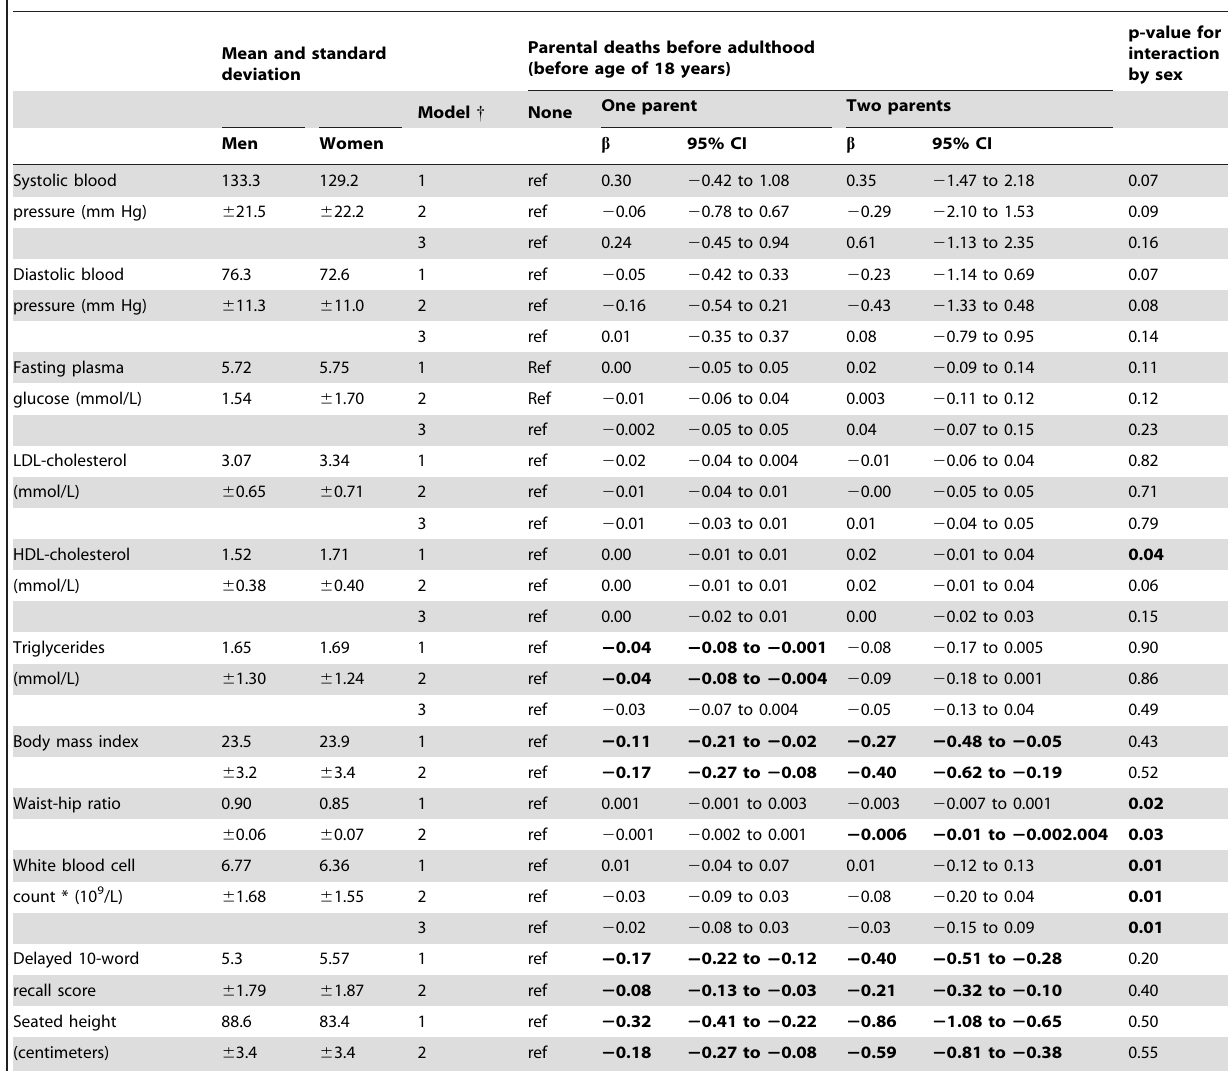
Table 2. Adjusted associations of early life parental death with cardiovascular risk factors, seated height and delayed 10-word recall score in 28,771 older Chinese men and women in recruitment phases 1, 2 and 3 of The Guangzhou Biobank Cohort Study